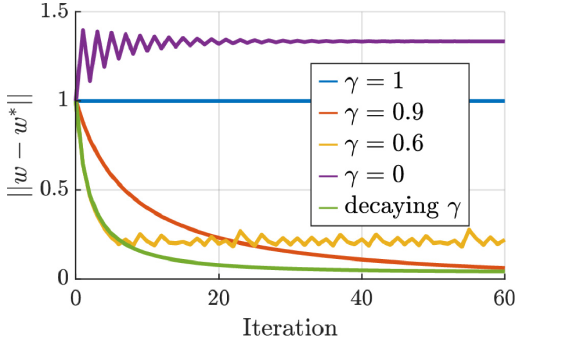
Fig 3. Visualization of the convergence behavior for different values of γ obtained from the two joints